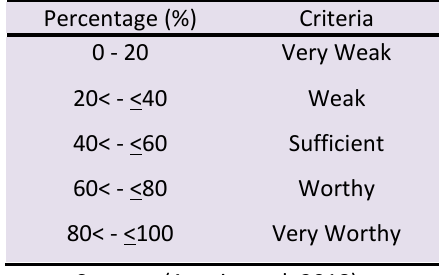
Table 2. Interpretation of Media Eligibilit